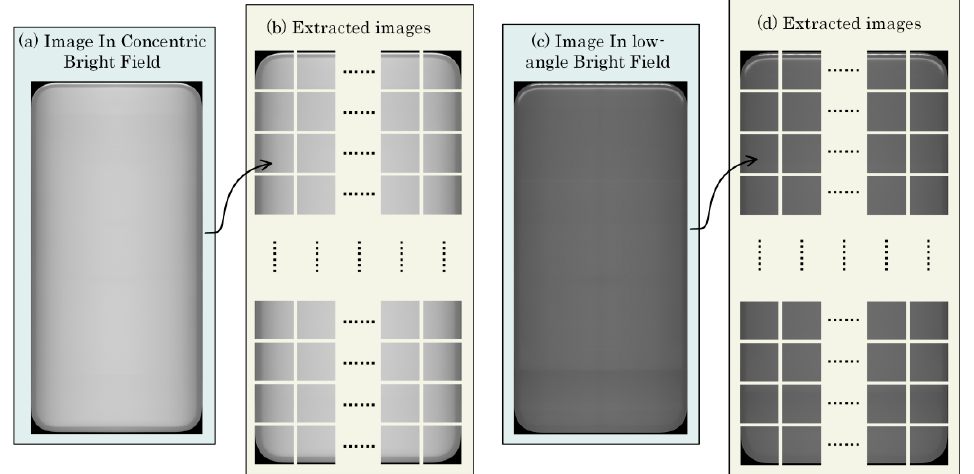
Figure 6. Typical captured images: ( a ) Original glass image captured by the CBF system; ( b ) extracted images by 23 rows and 12 columns from original image in ( a ); ( c ) Original image captured by the LABF system; ( d ) extracted images by 23 rows and 12 columns from original image in ( c